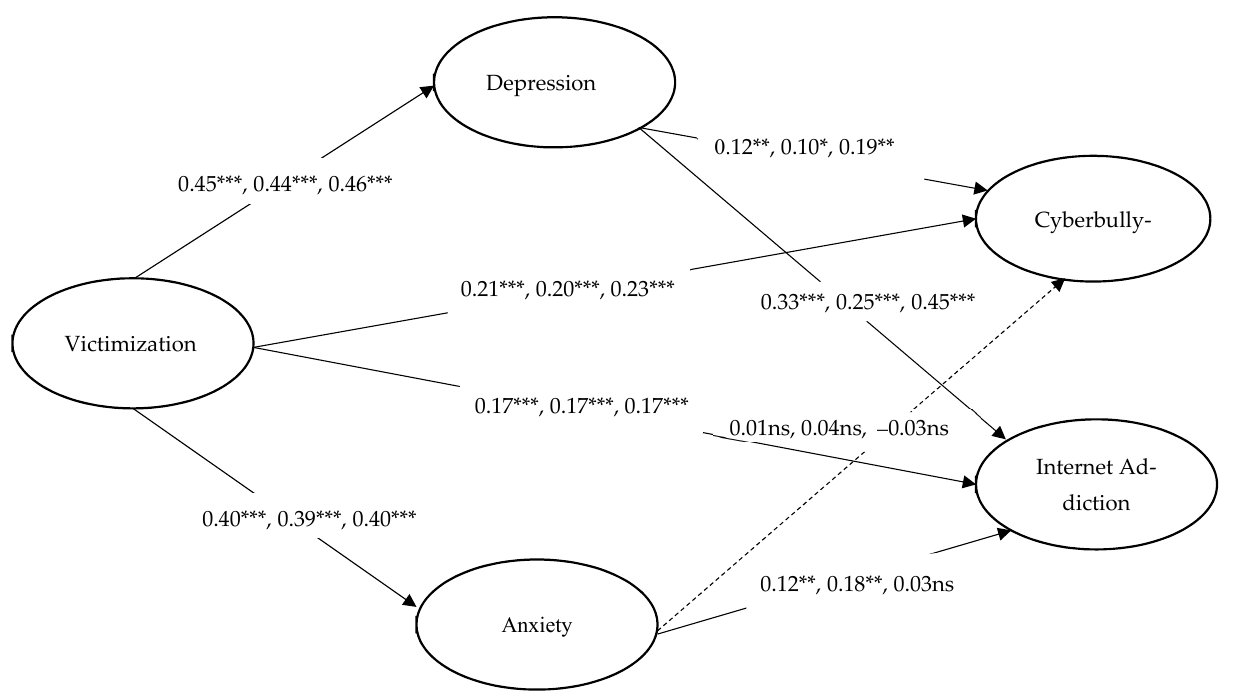
Figure 1. Structural equation model. Latent constructs are shown in ellipses. The standardized coefficients of all paths from left to right represent the entire, male, and female samples, respectively, *** p < 0.001; ** p < 0.01; * p = 0.05; ns = non-significant. Table 3. Multi-Group Test based on Gender.